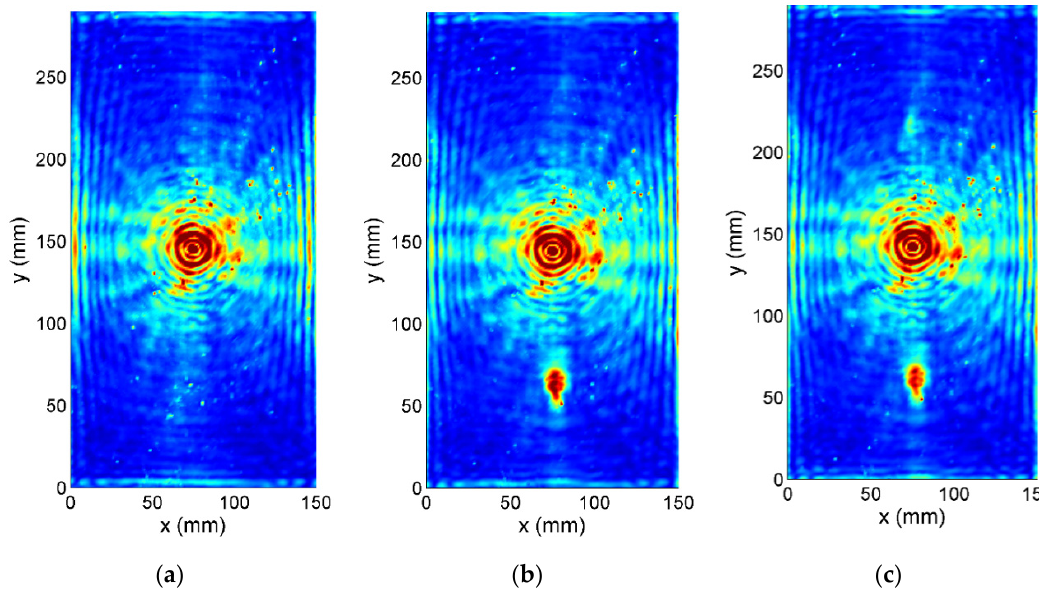
Figure 13. Damage maps: ( a ) pristine condition; ( b ) 1 h after 8 J impact; ( c ) 1 h after 5 J impact.